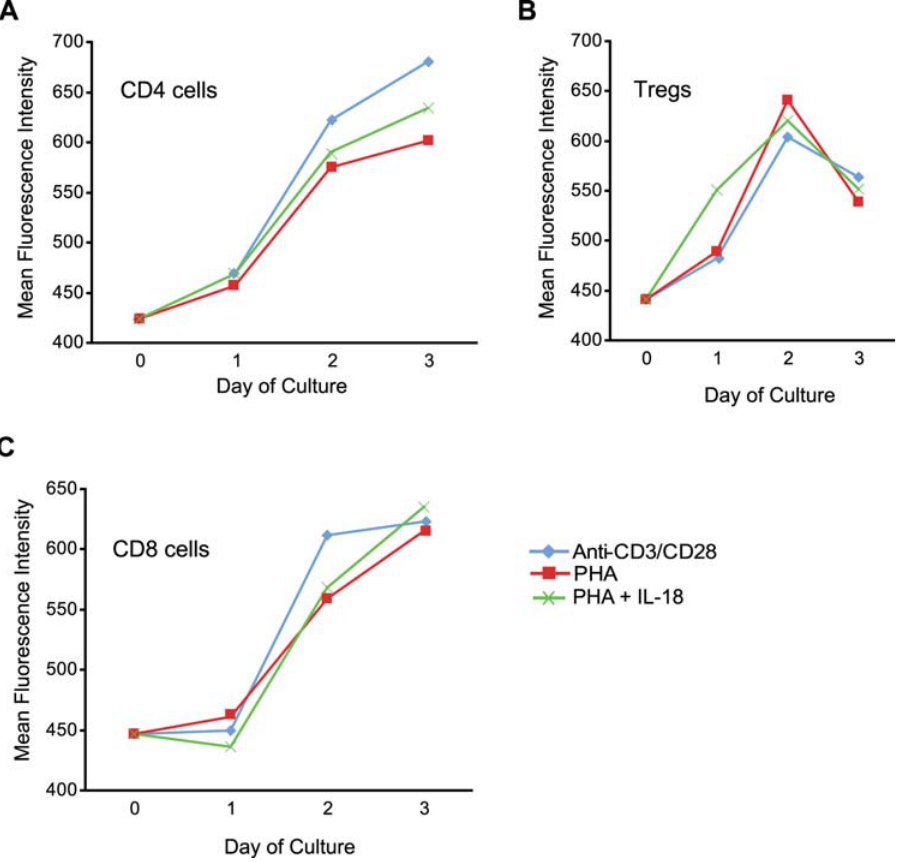
Figure 8. Rapid Down Regulation of IL18-R a on Tregs Following Cell Activation. Purified populations of Tregs, as well as bulk CD4 and CD8 cells, were activated with either a CD3/ a CD28 beads, PHA (5 m g/ml), or PHA + recombinant human IL-18 (500 ng/ml). IL-18R a expression was measured by flow cytometry. IL-18R a MFI on effector CD4 cells ( A ), Tregs ( B ) and effector CD8 cells ( C ) is plotted before stimulation and 1, 2, and 3 days following stimulation.